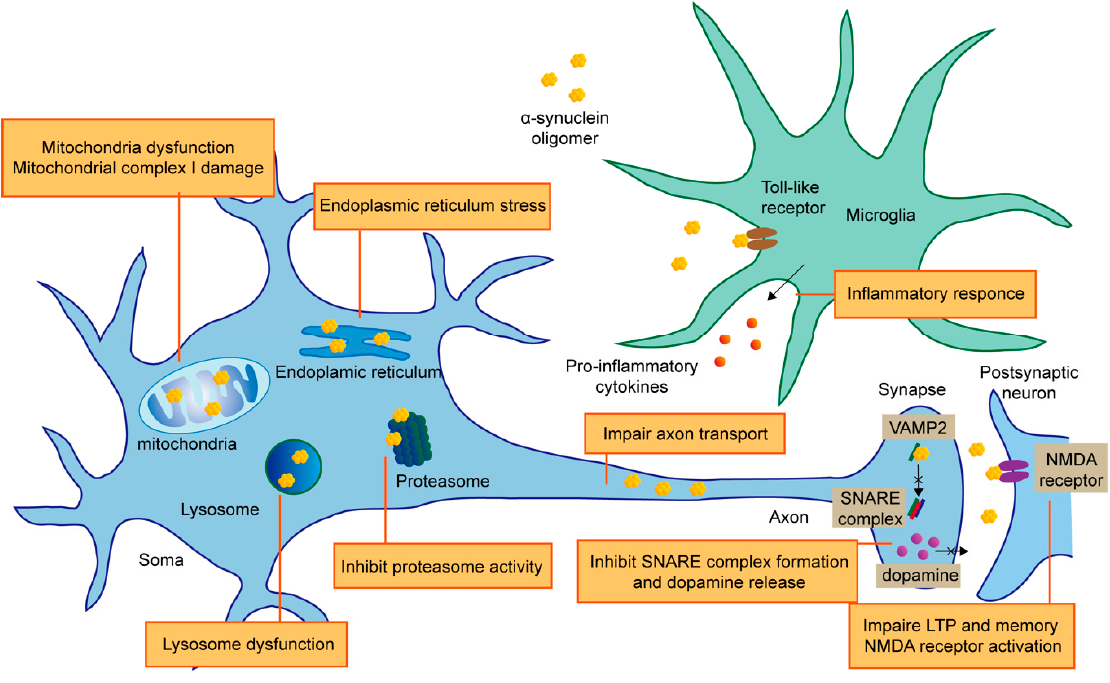
Figure 3. The mechanism of α -syn oligomers neurotoxicity. α -syn oligomers showing neurotoxic effects through multiple ways. Mitochondrial dysfunction can be triggered by α -syn oligomers through mitochondrial complex impairment and other kinds of mechanisms. Oligomeric α -syn uniquely lead to ER stress. The two main ways to maintain proteostasis, UPS and ALP, which are both affected by α -syn oligomers. Oligomers inhibit proteasome activity and cause lysosome dysfunction. α -syn is abundant in synapse while pathological α -syn oligomers damage synapse function via inhibiting SNARE complex formation and dopamine release. Some mutant α -syn oligomers have the ability to impair axon transport. α -syn oligomers also bind to NMDA receptor, resulting in membrane damage and LTP impairment. In addition to the direct cytotoxic effects on neurons, α -syn also participates in PD pathology by activating glial cells through toll-like receptor, giving rise to secretion of pro-inflammatory cytokines and neuron loss.